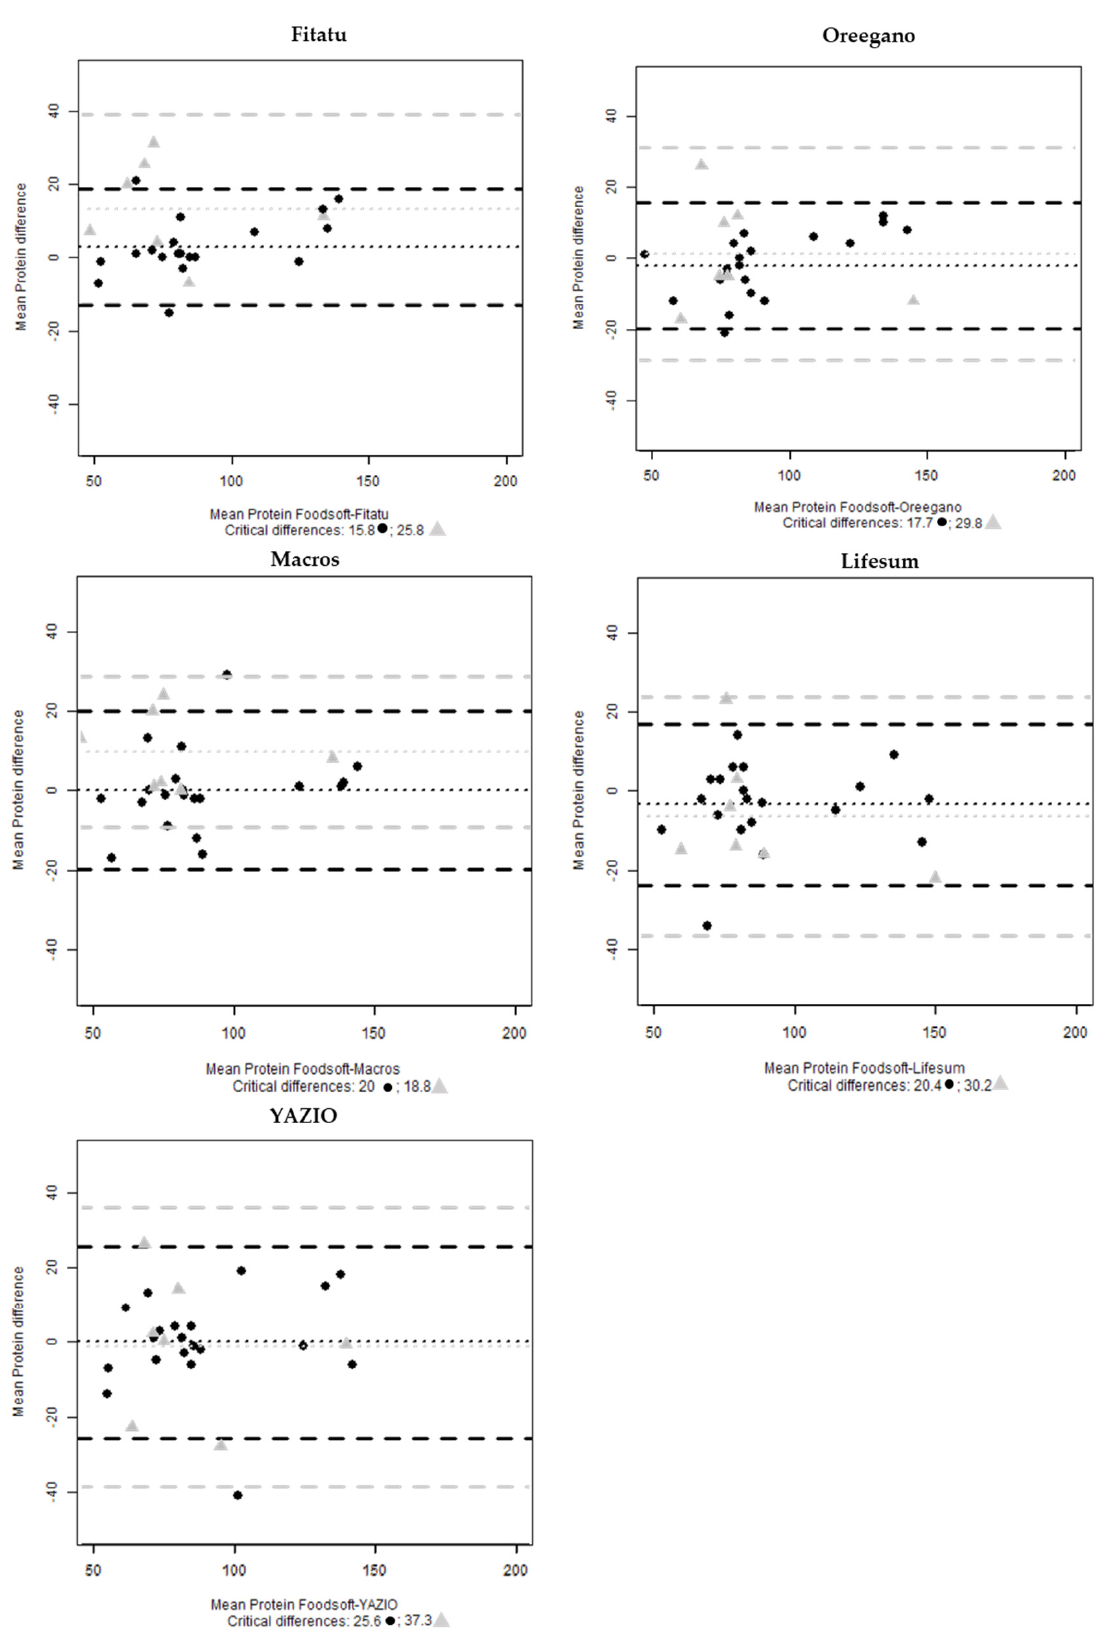
Figure 5 . Bland-Altman plots of mean protein (g) difference between Foodsoft 1.0 and Fitatu, Oreegano, Macros, YAZIO and Lifesum whole sample ( ● ) and the selected 24-HRs ( ).